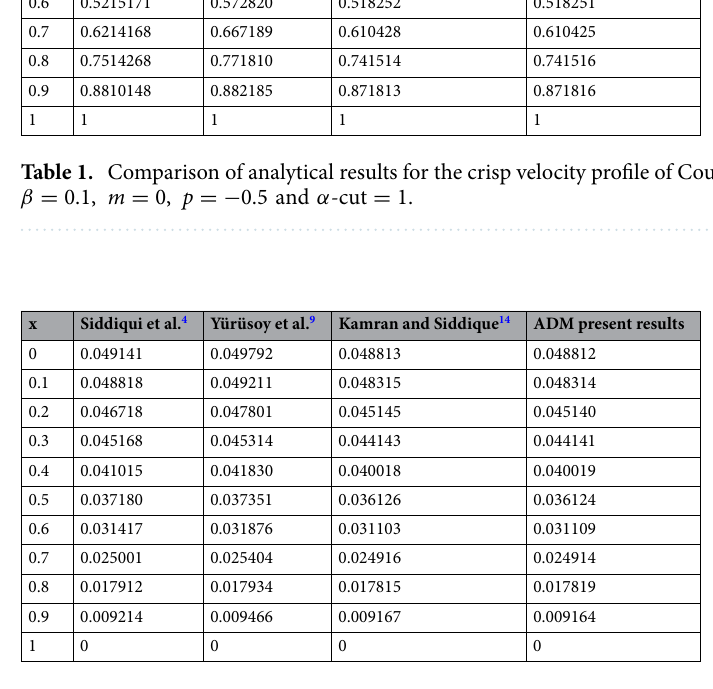
Table 2. Comparison of analytical results for the crisp velocity profile of Poiseuille flow when β = 0.1, m = 0, p = − 0.5 and α -cut =